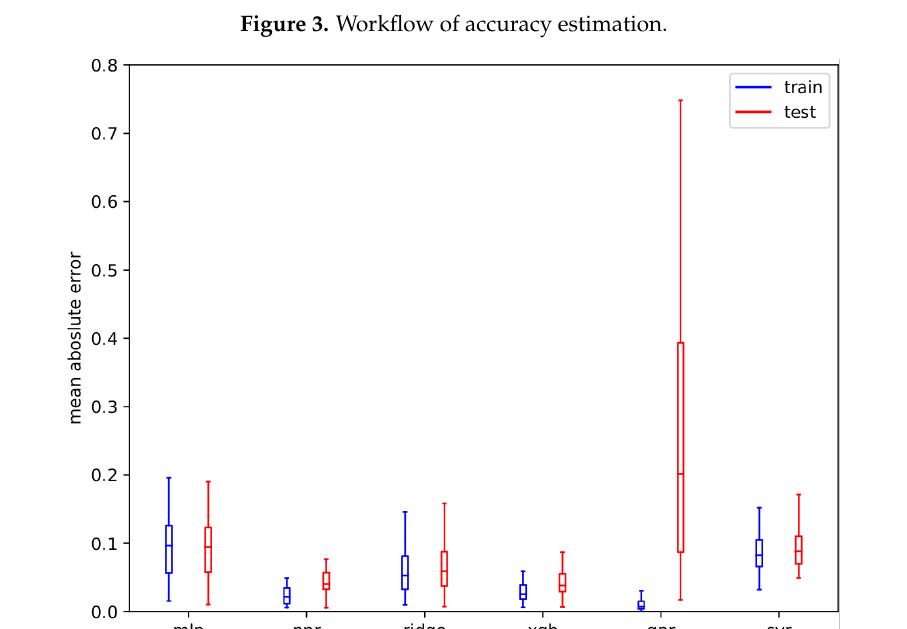
Figure 4. Comparison of regression models used for estimating ground-truth accuracy of several classifiers averaged on tested real-world data